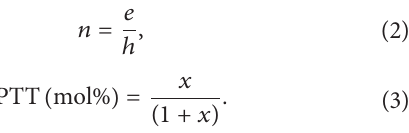
the phenyl group, and those vibrations at 1018 and 829 cm −1 correspond, respectively, to the C–H out-plane and in-plane deformation vibration of paradisplacement benzene